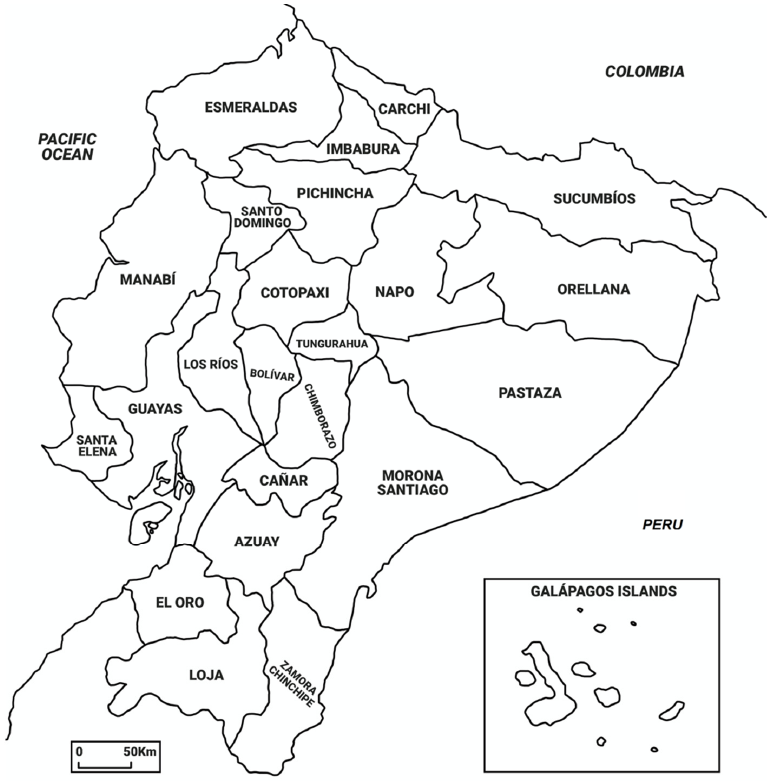
Figure 1. Provinces of Ecuador.